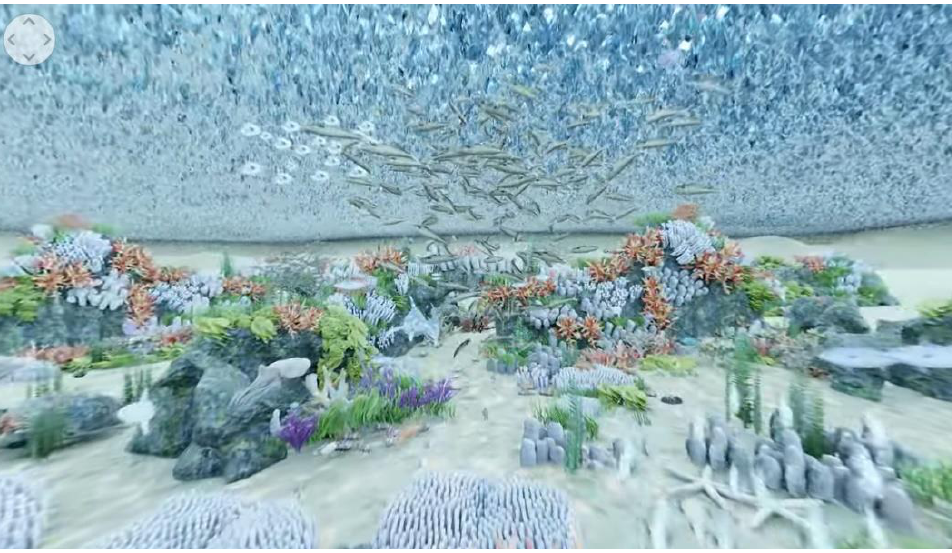
Figure 9. A schematic geological section used for animated modeling of the Umbria-Marche Miocene paleoenvironment. During the animation, the activation of normal faults is shown.